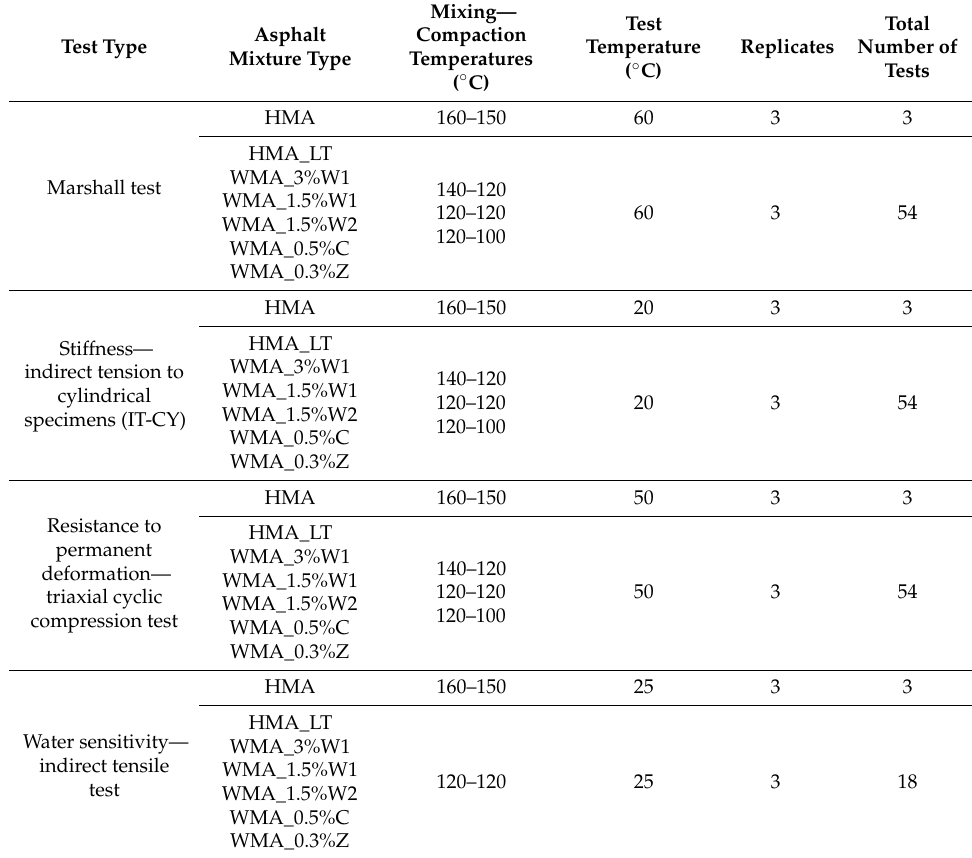
Table 1. Experimental plan for laboratory-mixed laboratory-compacted (LMLC) samples.